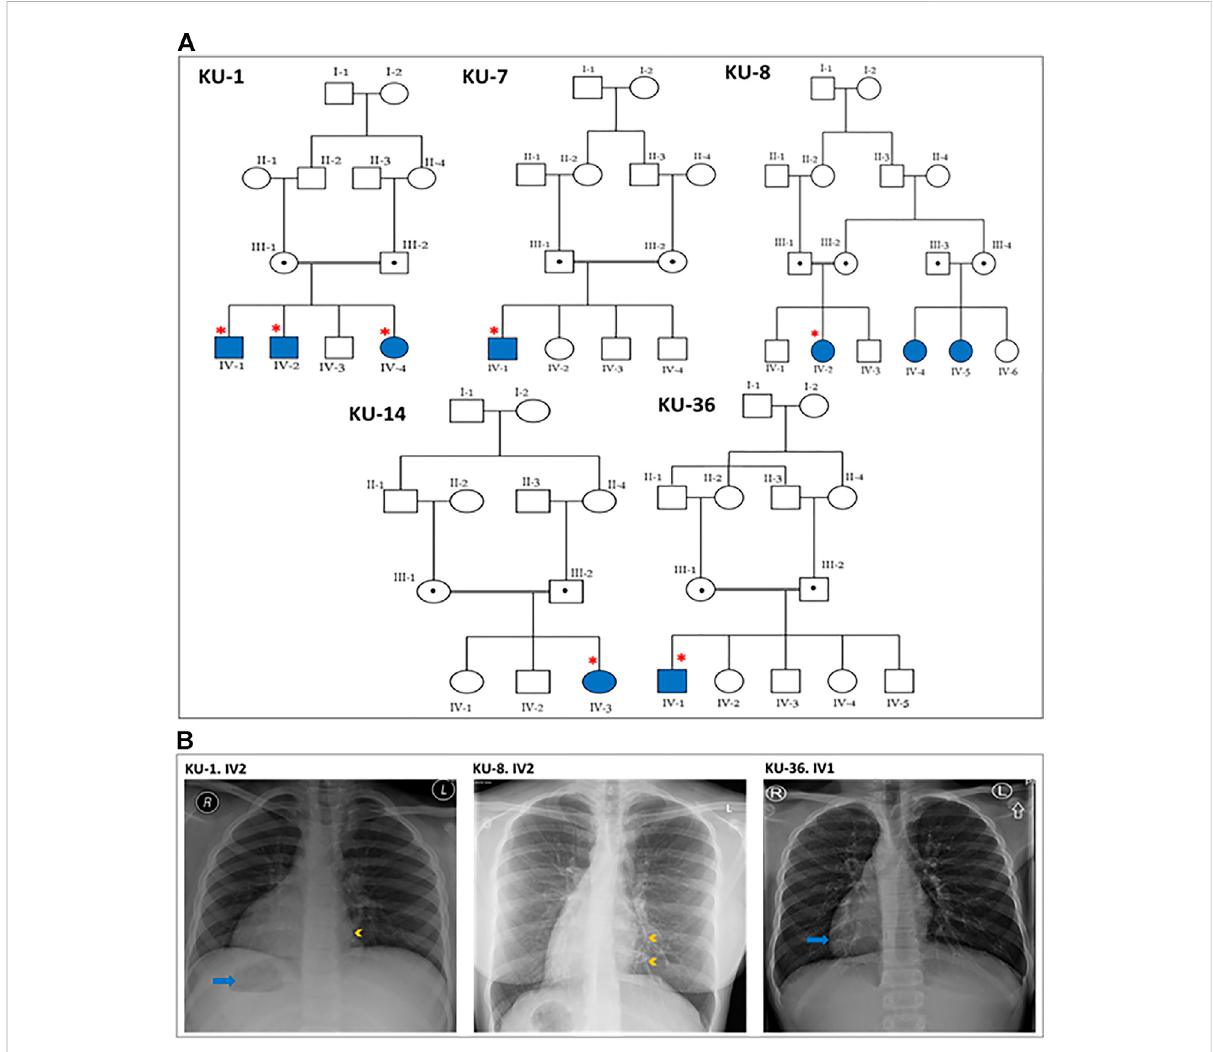
FIGURE 1 PedigreesandthechestX-raysforthePCDindividuals. (A) showsthe fi vepedigreesoffamiliesunderstudy.TheDNAsamplesandnasalbiopsies weretakenfromtheaffected individuals (highlighted withasterisks). ForKU-1.IV2 patient,onlyDNAsamplesweretakenlaterfor Sangersequencing. (B) shows selected chest X-rays for three of the patients. The three patients have dextrocardia and a right-sided gastric shadow (arrow), in keeping with situs inversus . Patient KU-1.IV2 has a small patch of consolidation seen in the paracardiac region of the left lung (arrowhead). Patient KU- 8.IV2 has diffuse bronchiectasis as seen in the medial left lower zone (arrowheads). Patient KU-36.IV1 shows dextrocardia (arrow) consistent with situs inversus